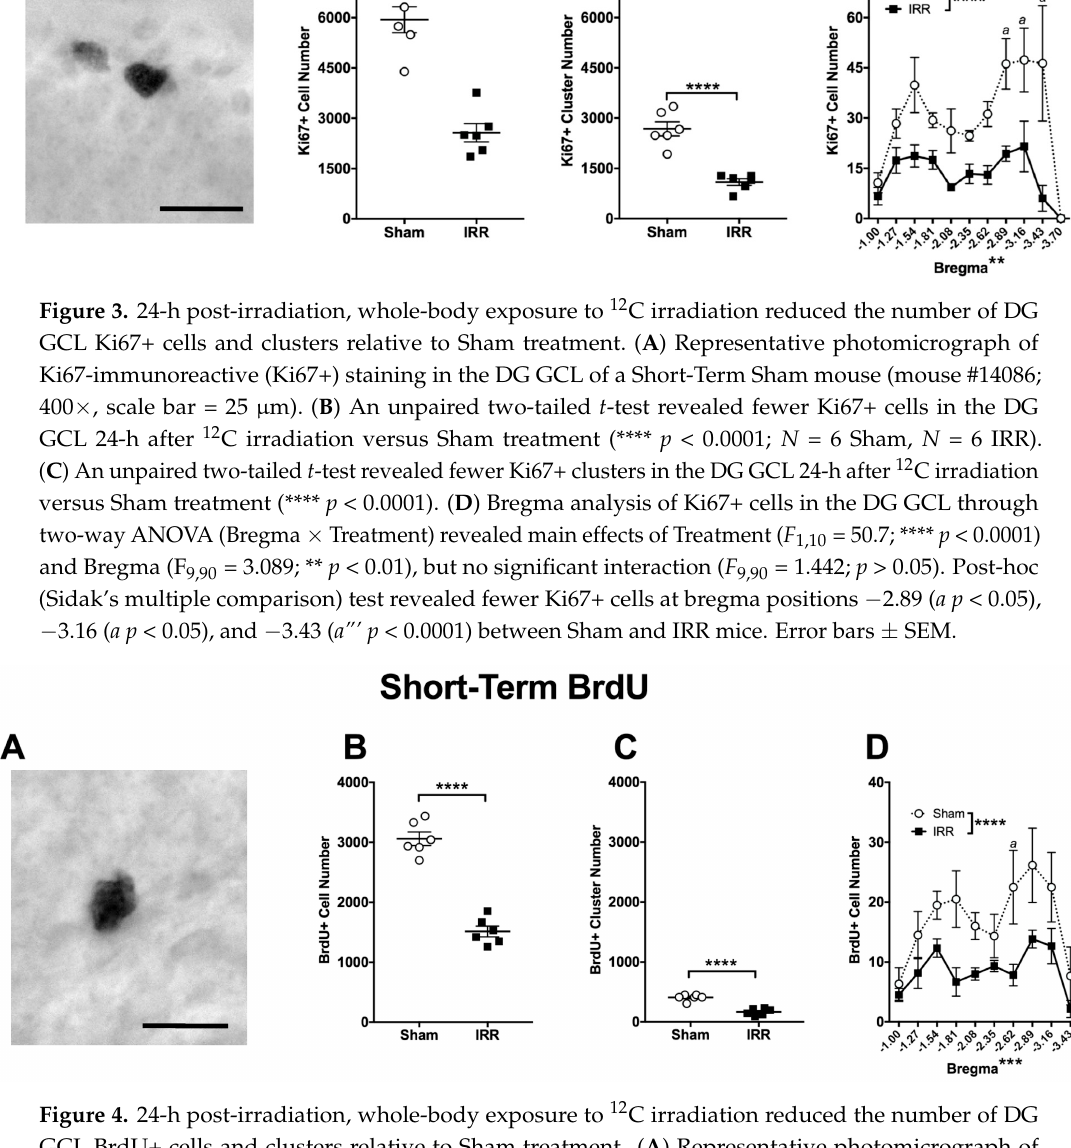
Bregma (F 9,90 = 3.089; ** p < 0.01), but no significant interaction ( F 9,90 = 1.442; p > 0.05). Post-hoc (Sidak’s multiple comparison) test revealed fewer Ki67+ cells at bregma positions − 2.89 ( a p < 0.05), − 3.16 ( a p < 0.05), and − 3.43 ( a’’’ p < 0.0001) between Sham and IRR mice. Error bars ± SEM.